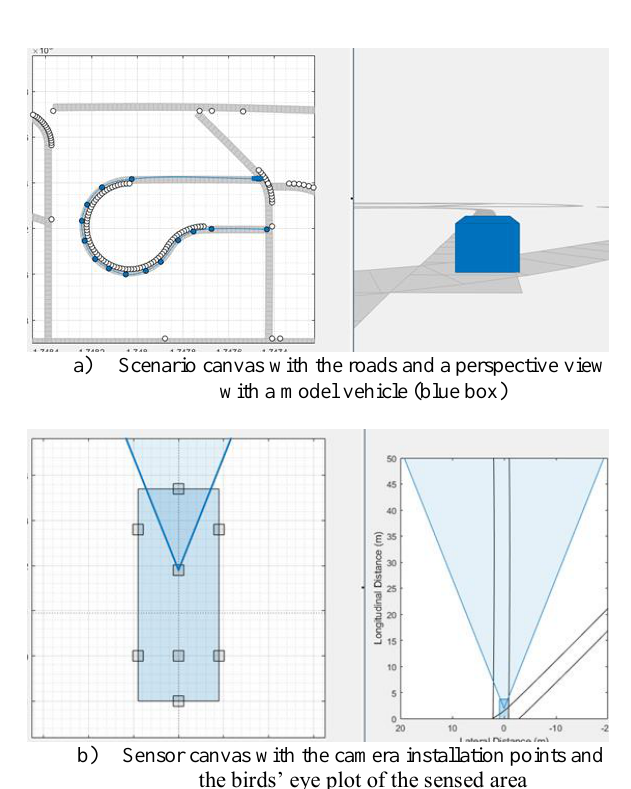
Figure 3. Driving Scenario Designer in Matlab with road network definition in OpenDRIVE